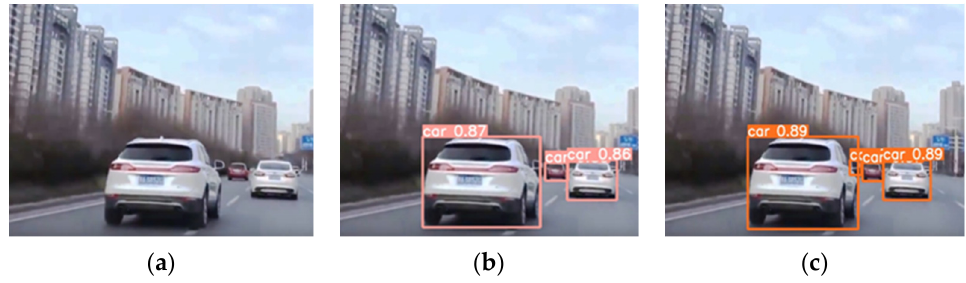
Figure 11. Visualization comparison before and after activation function improvement.